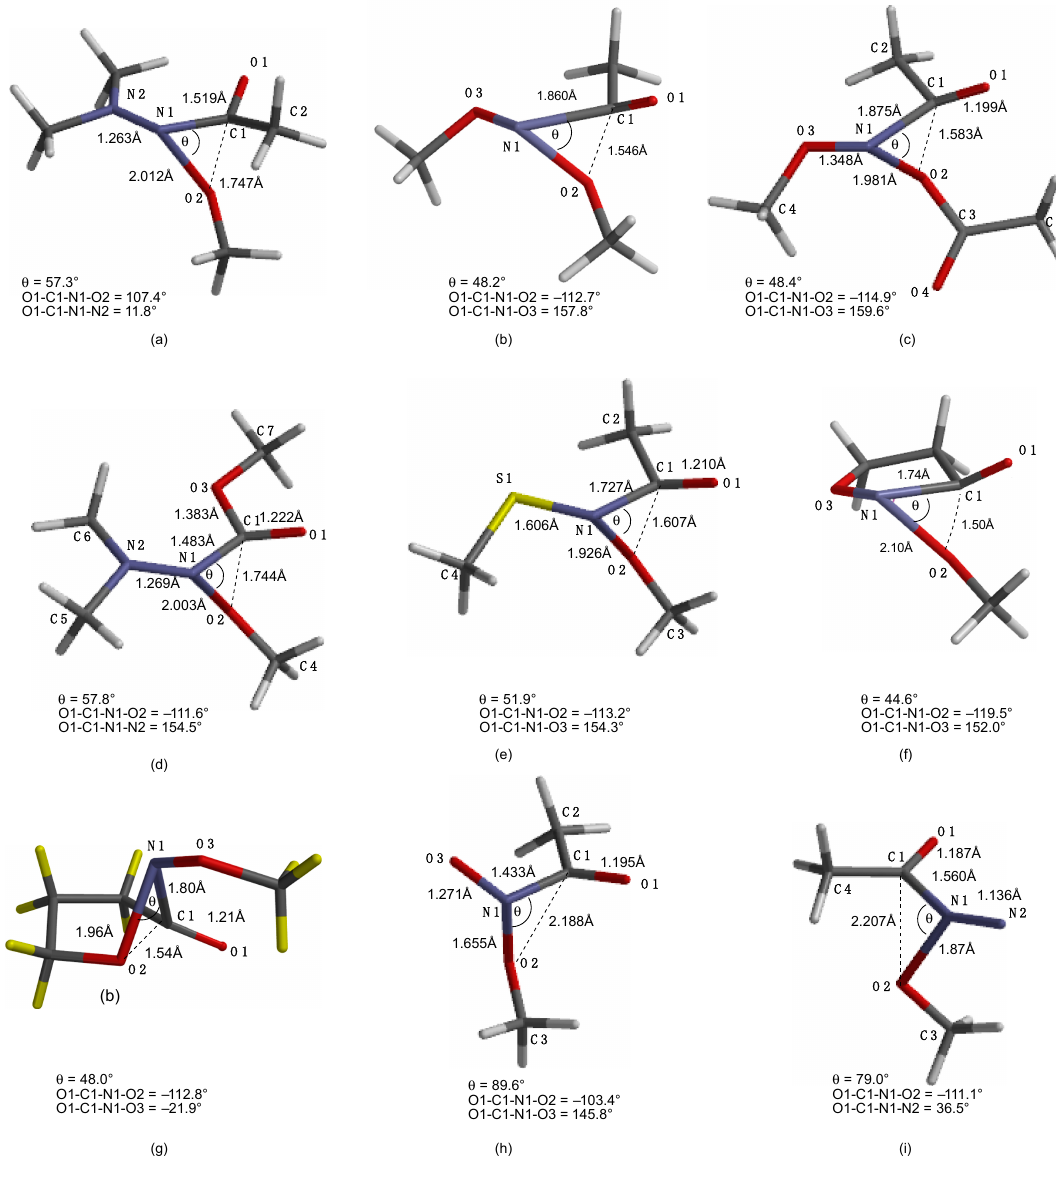
Figure 17. B3LYP/6-31G(d) optimised transition states of favoured HERON reactions of ( a ) N -methoxy- N -dimethylaminoacetamide 15c , ( b ) N , N -dimethoxyacetamide 4b , ( c ) N -acetoxy- N -methoxyamide 15b , ( d ) O -methyl- N -methoxy- N -dimethylaminocarbamate 16a , ( e ) N -methoxy- N -methylthiylacetamide 15d , ( f ) N -methoxy- γ -oxazinolactam 81 (ring opening), ( g ) N -methoxy- δ -oxazinolactam 82 (ring contraction), ( h ) N -methoxyacetohydroxamate 15f and ( i ) 1-acetyl-1-methoxydiazene 15g .